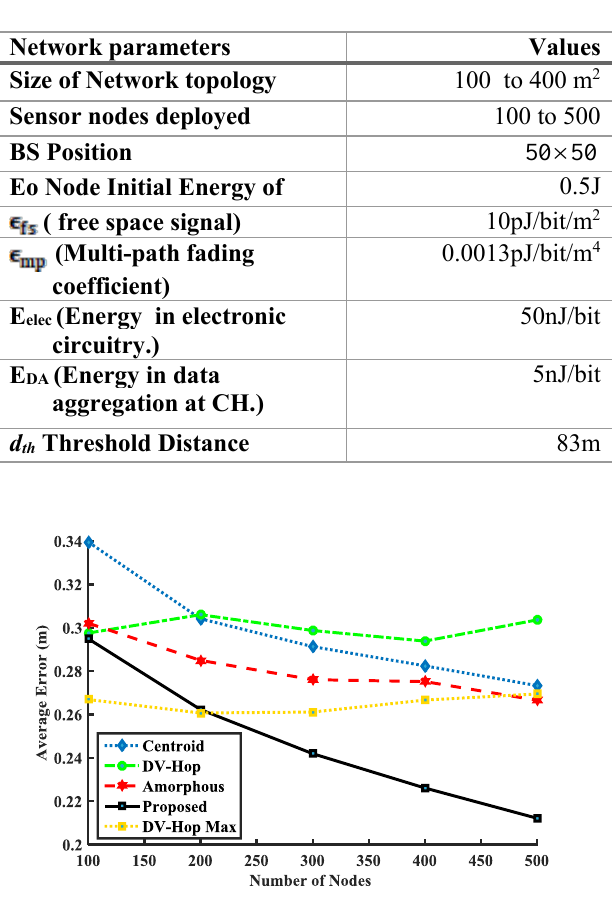
Fig. 4 Average localization Error Vs number of nodes with topology size (250×250) m 2